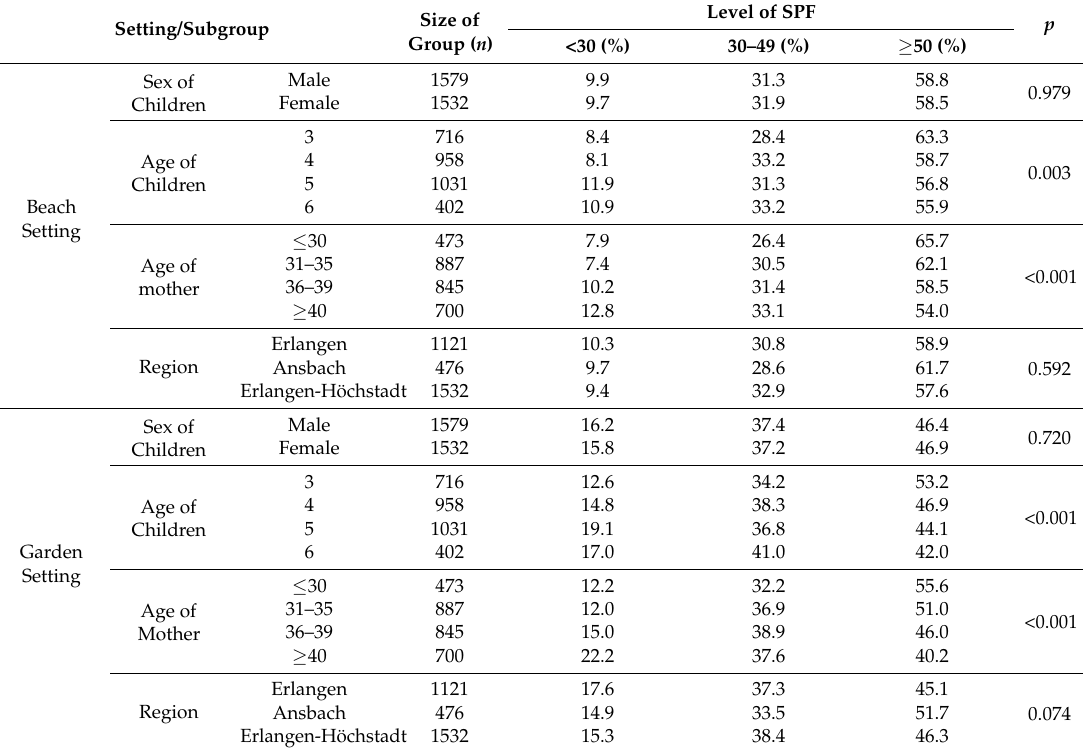
Table 5. Level of sun protection factor (SPF) when using sunscreens in two outdoor settings (beach —upper part and garden—lower part) based on answers of 3129 parents of three- to six-year old children in the Erlking-II-study in three Bavarian districts in Southern